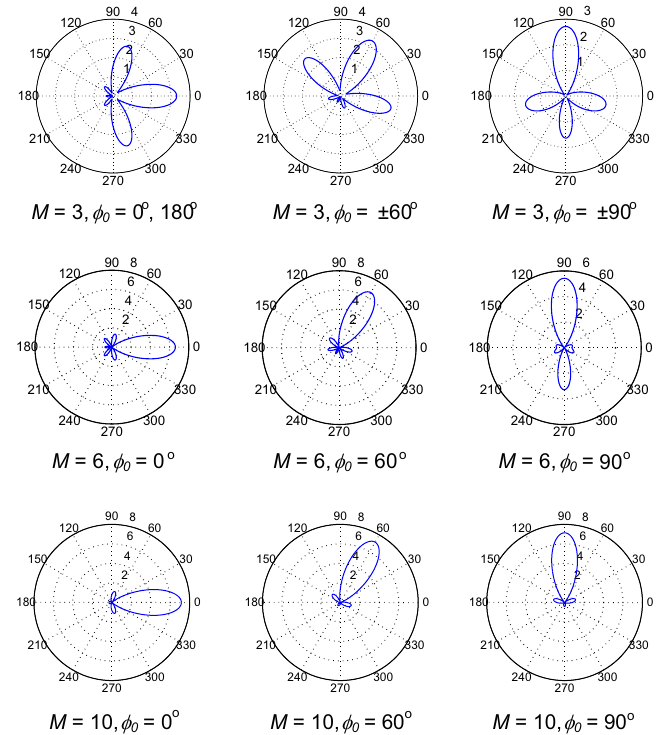
Figure 3. Gain patterns of UCA as the numbers of antenna elements and main beam directions are